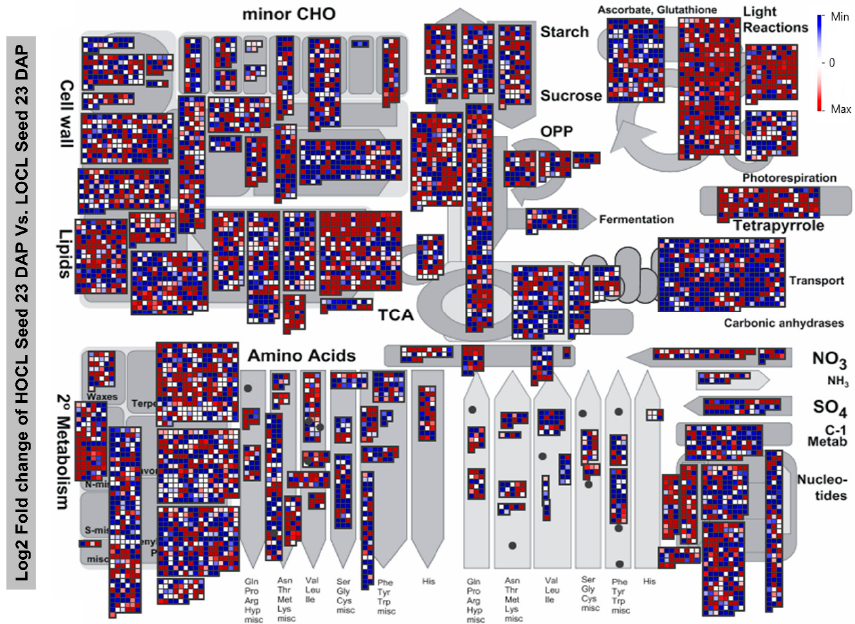
Figure 3. Expressed genes in seed tissue at 23 DAP involved in major pathways revealed by MapMan. A total of 7175 genes are visible in data points. Red dots represent genes expressed preferentially in the HOCL, and blue, those expressed in the LOCL.